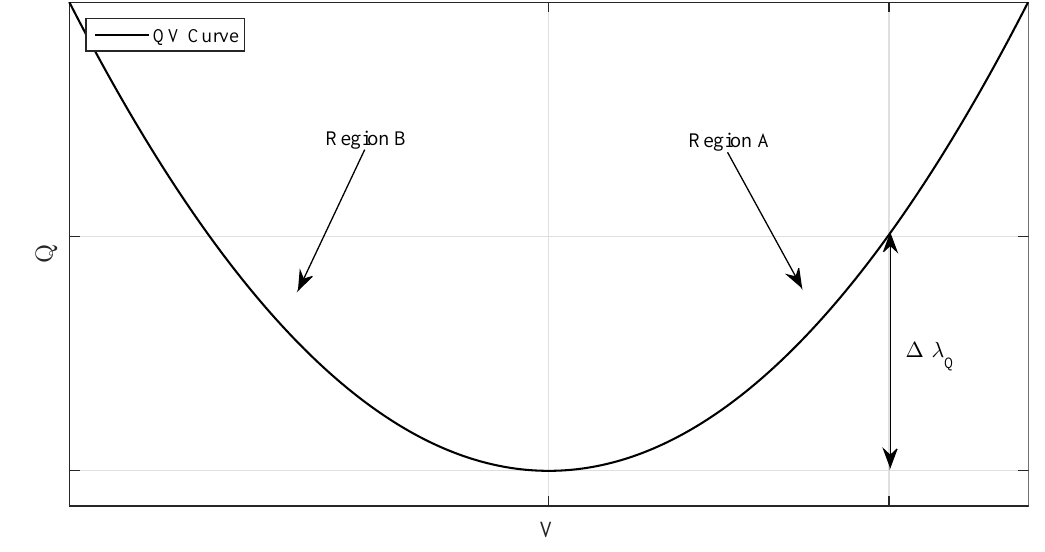
Figure 1. Regions of operation in a QV